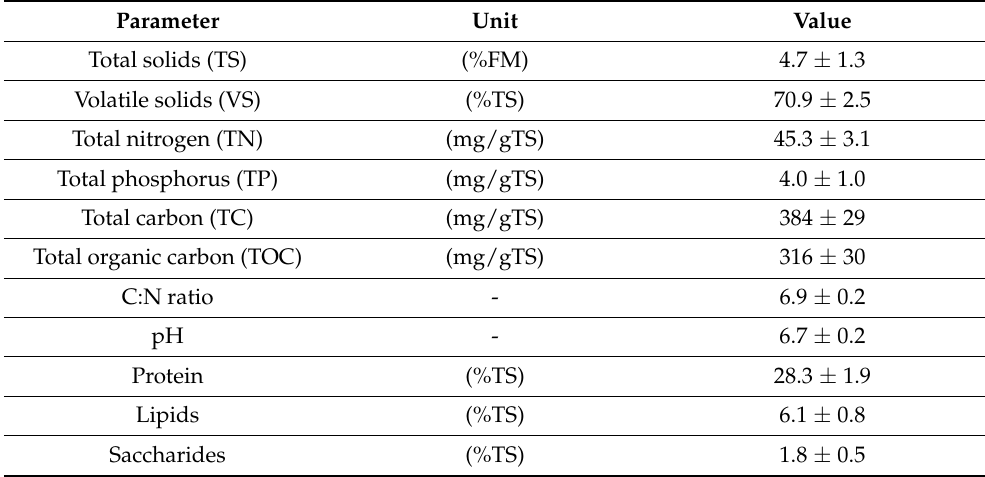
Table 3. Characteristics of anaerobic sludge used as the inoculum in respirometric